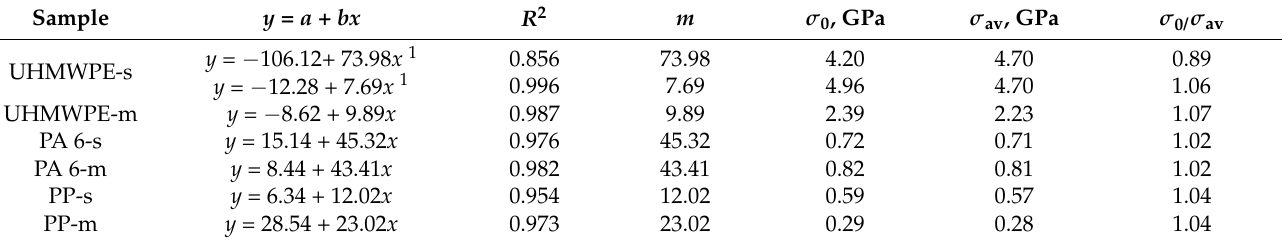
Figure 1. ( a ) Stress–strain curves for single (s) and multifilament (m) fibers of UHMWPE, PA 6 and PP recorded at a cross-head speed of 200 mm/min and an initial distance between the tester clamps of 500 mm; ( b ) Scheme of the stress–strain curve analysis for a PA 6 multifilament fiber. Table 1. Results of Weibull’s analysis of the strength distribution of high-performance single (s) and multifilament (m) fibers of UHMWPE, PA 6 and PP.